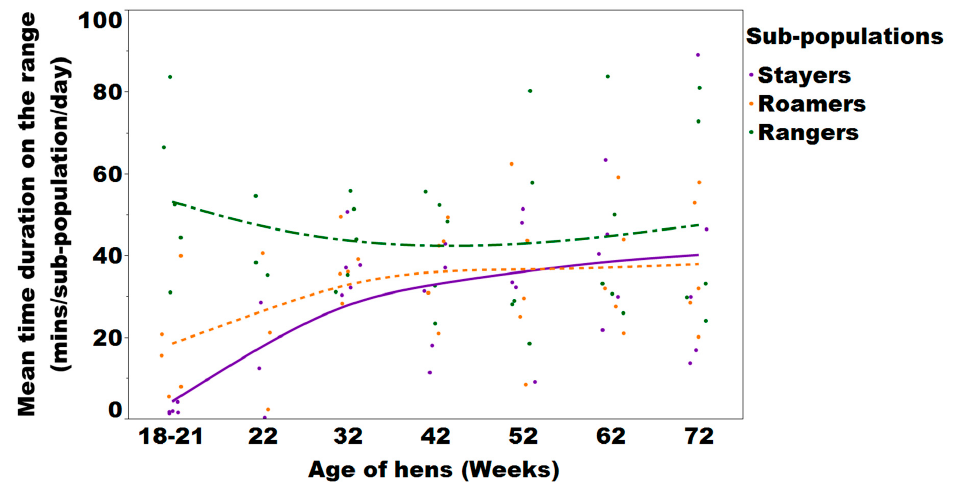
Figure 4. Trend lines and mean values that flock sub-populations spent on the range expressed as minutes / flock / day of the subpopulation of stayers, roamers, and rangers in Lohmann brown free-range laying hens during egg collection period of 22, 32, 42, 52, 62 and 72 weeks of age evaluated in 5 flocks. Each dot on the plot represents the average time duration that one sub-population replicate spent on the range.